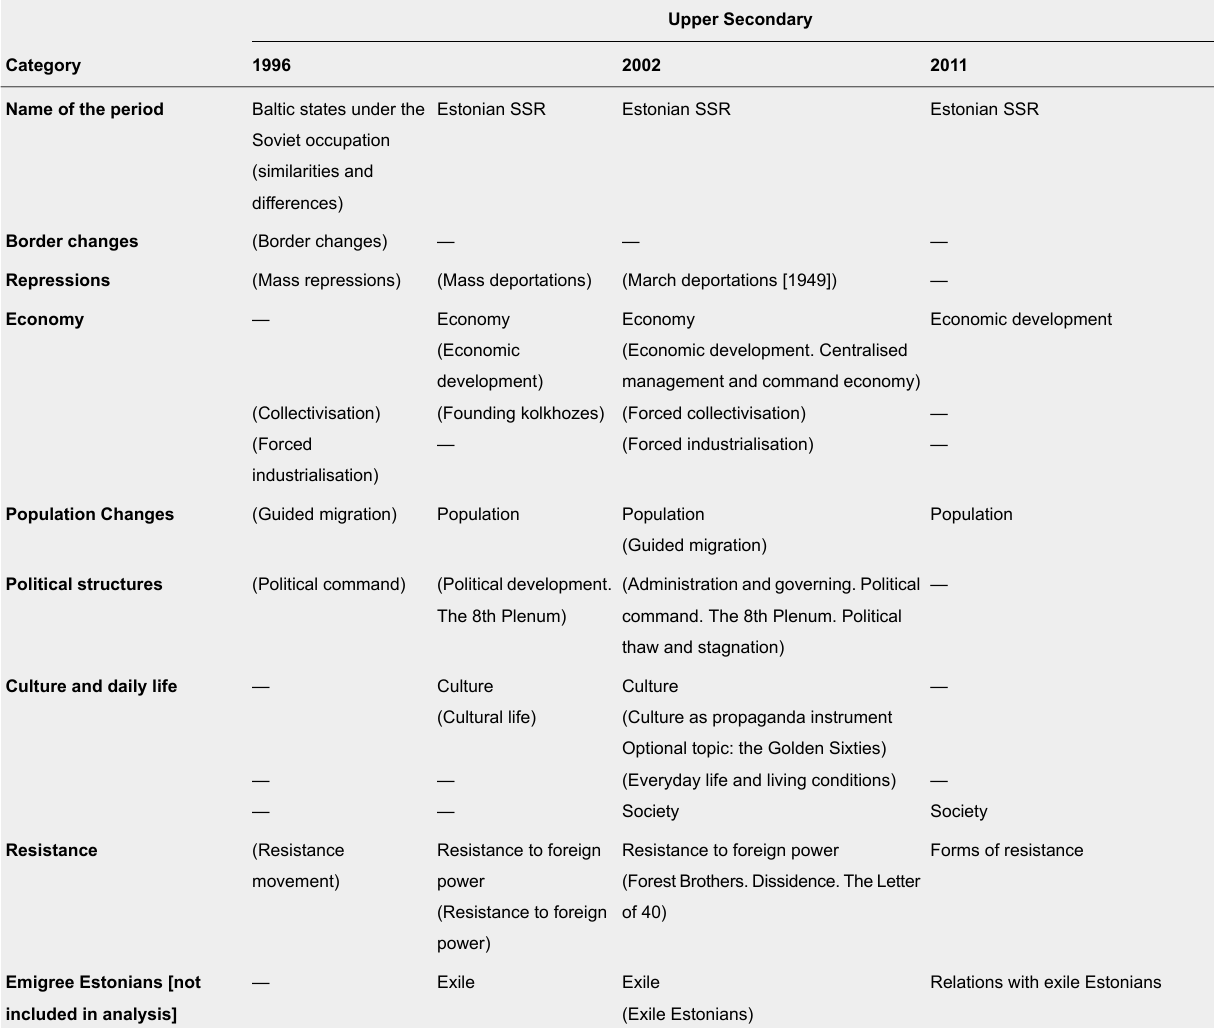
Keywords Related to the Post-WW2 Soviet-Era (From 1945 to 1985) in Estonia or Baltic Countries Present in the Estonian National Curricula and Commentaries That Accompany the Respective